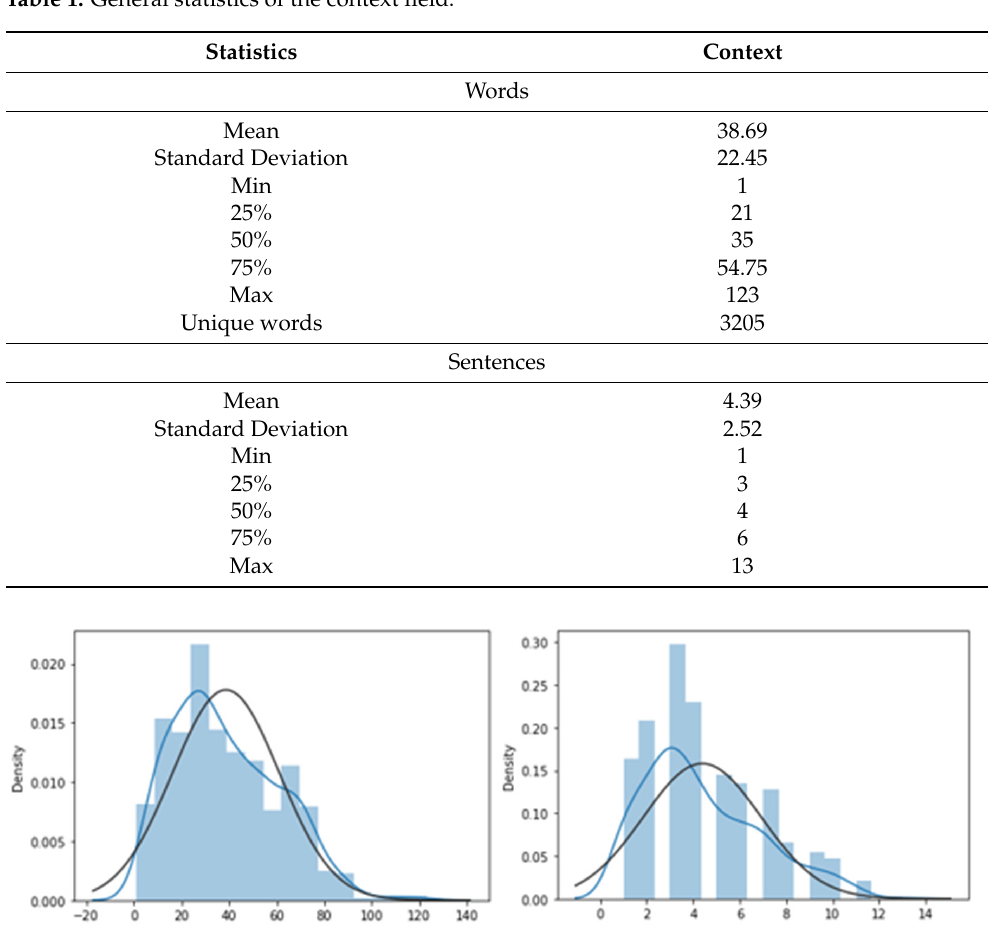
Figure 1. Words’ ( left ) and sentences’ ( right ) distribution of MUStARD context. Data distribution (blue line) vs Normal distribution (black line).